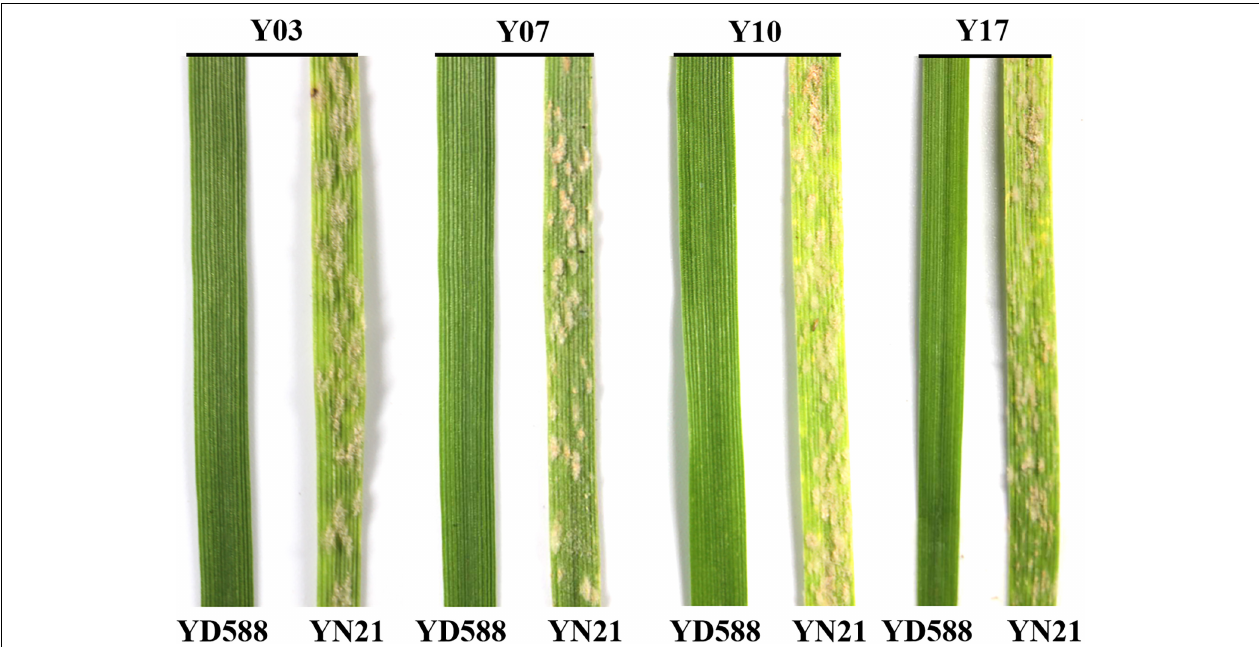
FIGURE 1 | Seedling reaction patterns of YD588 and Yannong 21 (YN21) to the selected four Blumeria graminis f. sp. tritici ( Bgt ) isolates collected from different regions of China.